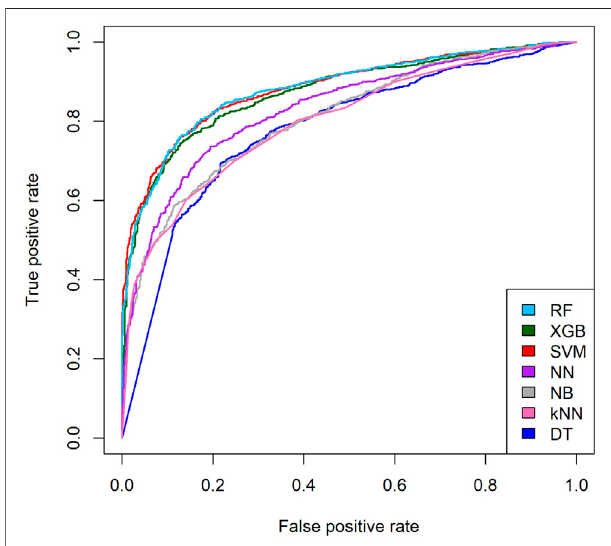
FIGURE 6 | ROC curves of individual machine learning